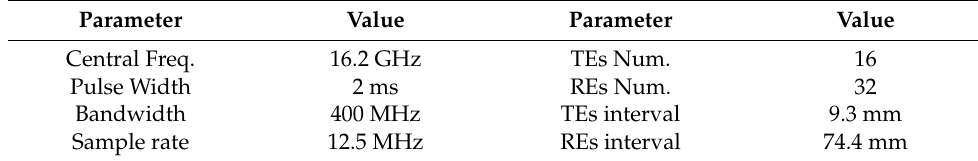
Table 3. System parameters.